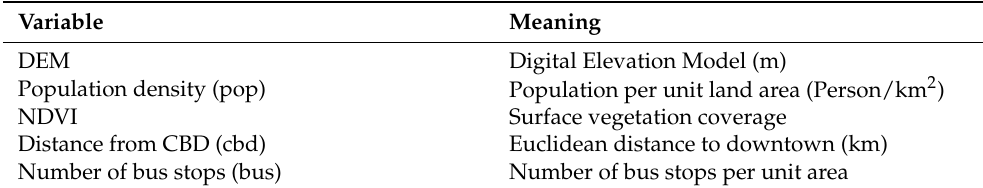
Table 2. Influencing factors of urban spatial fragmentation and its meaning.